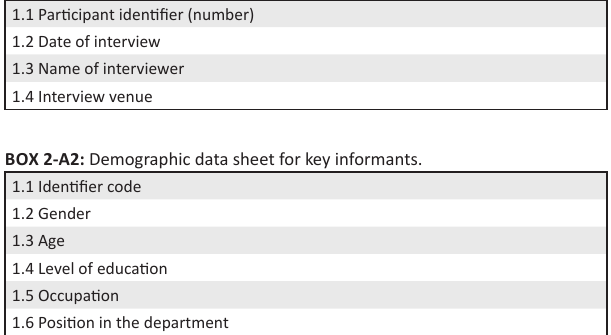
TABLE 2-A2: Interview guide